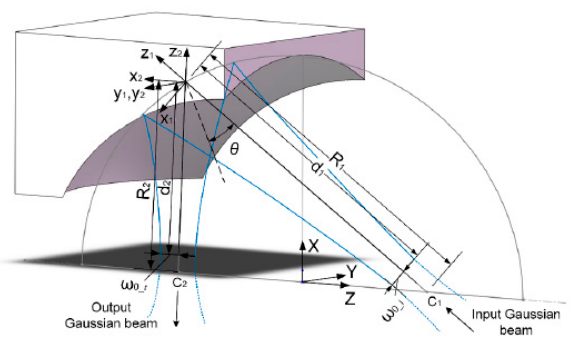
Figure 1. Geometry of an off-axis ellipsoidal mirror with the input and output beams in the local coordinate